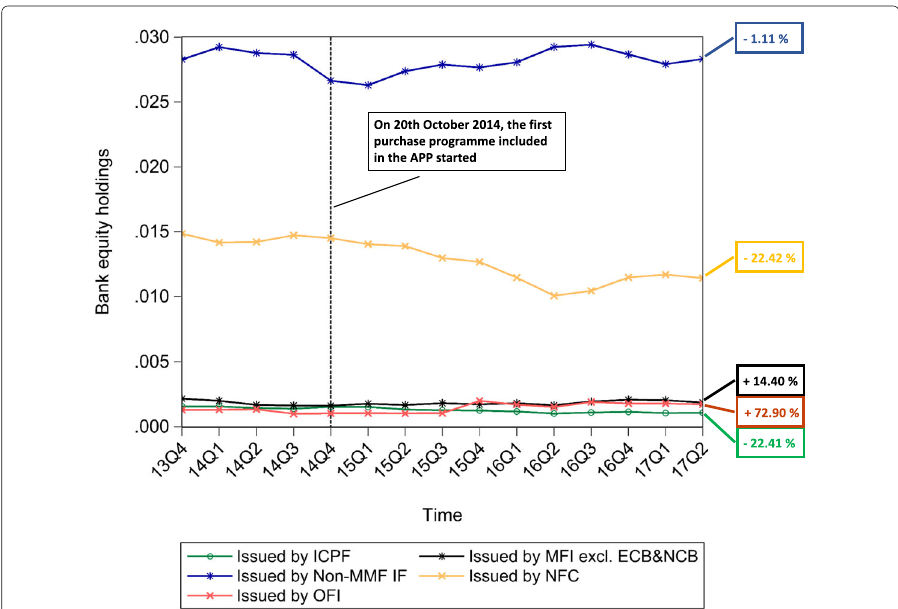
Fig. 14 Bank equity holdings - breakdown by counterparty sector; 2013Q4-2017Q2. Time series of the breakdown of equity (including listed, unlisted, and investment fund shares) held by the euro area Monetary Financial Instutions excluding the Eurosystem by issuing counterparty sector, i.e., Monetary Financial Institutions excluding the Eurosystem (MFI excl. ECB&NCB, in black), Other Financial Institutions (OFI, in pink), Non-MMF Investment Funds (Non-MMF IF, in dark blue), Insurance Corporations and Pension Funds (IC&PF, in green), and Non-Financial Corporations (NFC, in yellow), over the reference period 2013Q4-2017Q2. The aforementioned time series are normalized by Monetary Financial Institutions excluding the Eurosystem total financial assets. The vertical dashed line corresponds to the beginning of the first purchase programme (3rd Covered Bond Purchase Programme, CBPP3) included in the APP, started in 2014Q4, while the percentages on the right-hand side of the graph correspond to our estimate of the growth rates of bank exposures in terms of equity to the different institutional sectors of the euro area, since the initiation of QE. Data source: (European Central Bank